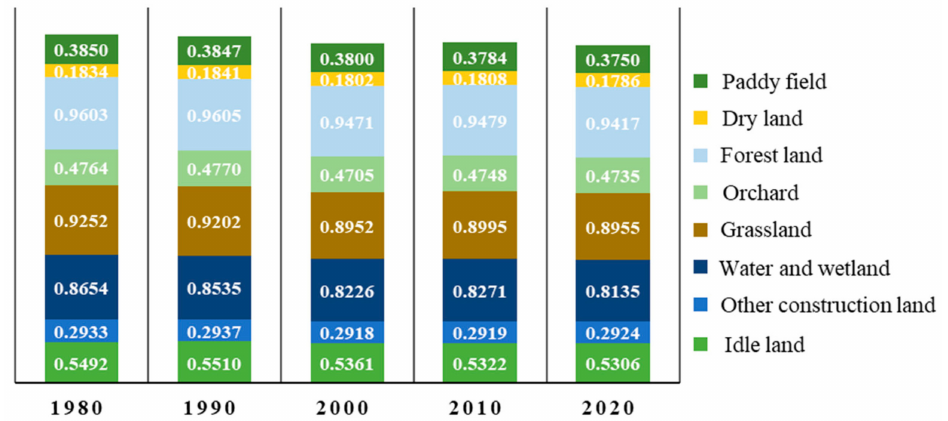
Figure 10. Annual average habitat quality of different land use types from 1980 to 2020. (Note: the annual average habitat quality of urban land and rural settlement is 0). Land use change has both positive and negative impacts on habitat quality. Table 3